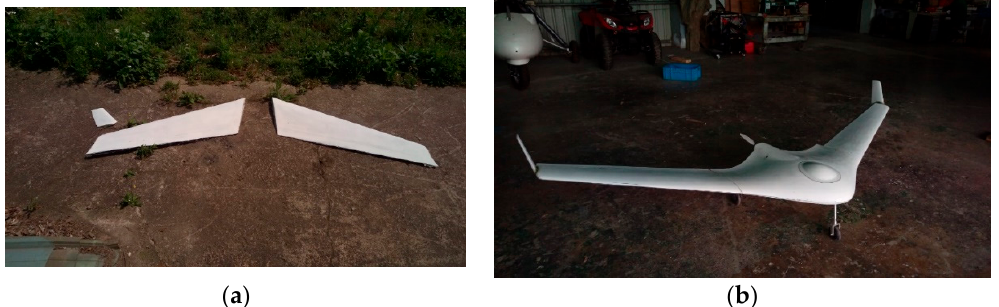
Figure 13. ( a ) Main structural modules (left and right wings) and secondary structural modules (wing